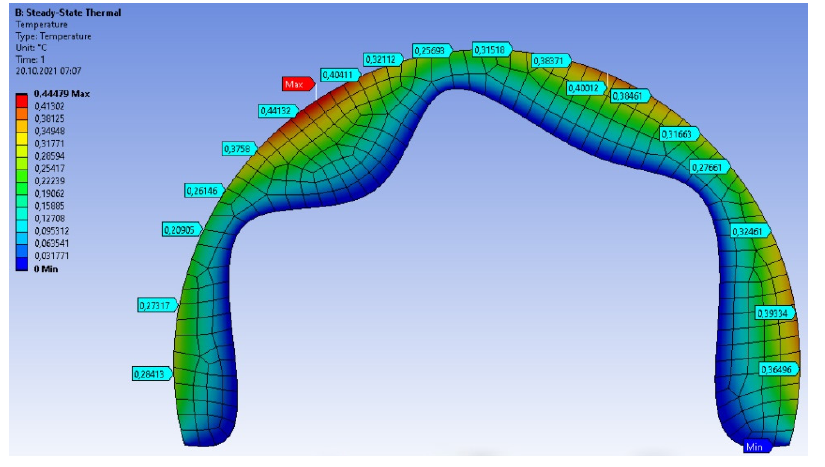
Appl. Sci. 2021 , 11 , x FOR PEER REVIEW Figure 6. Randomly marked points. Figure 6. Randomly marked points.